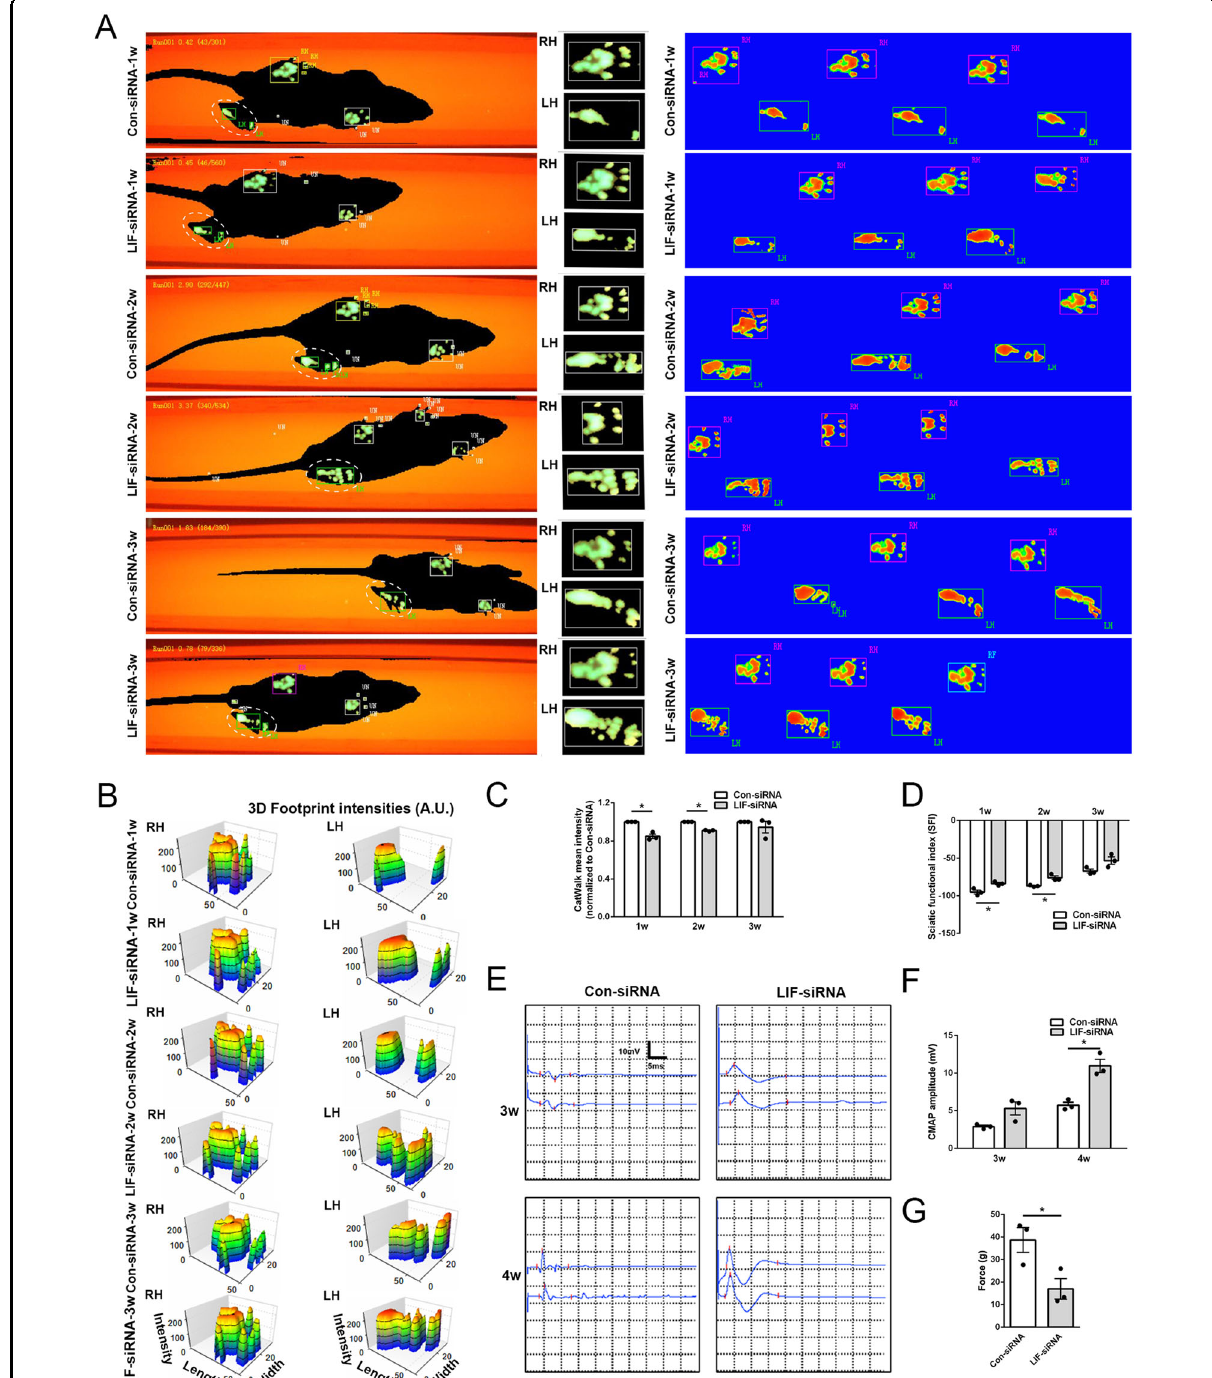
Fig. 6 LIF-siRNA stimulates nerve functional recovery. A Representative footprint images of rats injected with control-siRNA or LIF-siRNA at 1 week, 2 weeks, and 3 weeks after nerve crush injury. LH indicates the left hindpaw (injured site) and RH indicates right hindpaw (uninjured site). B Measurement of 3D footprint intensities of rats injected with control-siRNA or LIF-siRNA at 1 week, 2 weeks, and 3 weeks after nerve crush injury. C Quanti fi cation of relative CatWalk mean intensity of rats injected with control-siRNA or LIF-siRNA at 1 week, 2 weeks, and 3 weeks after nerve crush injury. D Quanti fi cation of SFI of rats injected with Control-siRNA or LIF-siRNA at 1 week, 2 weeks, and 3 weeks after nerve crush injury. E Representative CMAP recordings of rats injected with control-siRNA or LIF-siRNA at 3 weeks and 4 weeks after nerve crush injury. F Quanti fi cation of peak amplitude in rats injected with control-siRNA or LIF-siRNA at 3 weeks and 4 weeks after nerve crush injury. G Quanti fi cation of response to mechanical allodynia in rats injected with control-siRNA or LIF-siRNA at 4 weeks after nerve crush injury. Data were presented as means ± SEM. * p value <0.05 versus control-siRNA